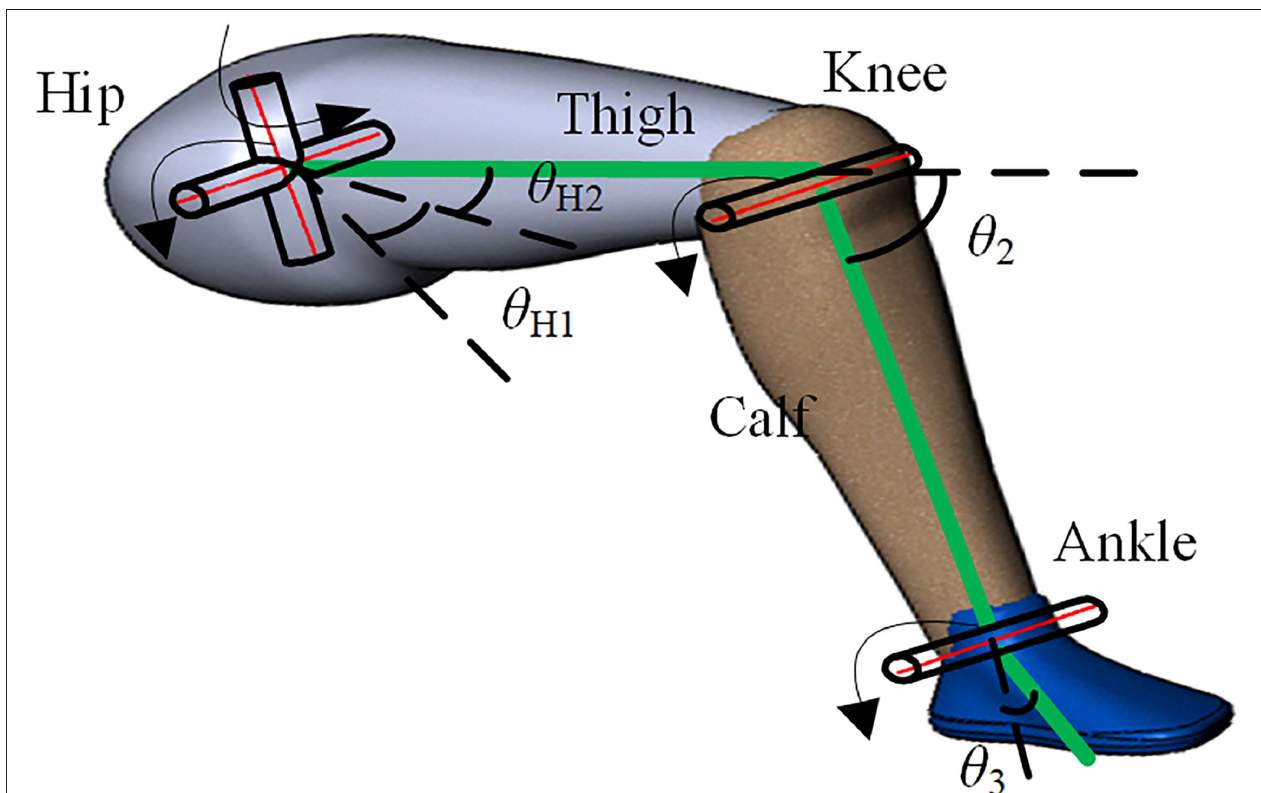
FIGURE 1 | Spatial motion diagram of rigid linkage mechanism of the human lower